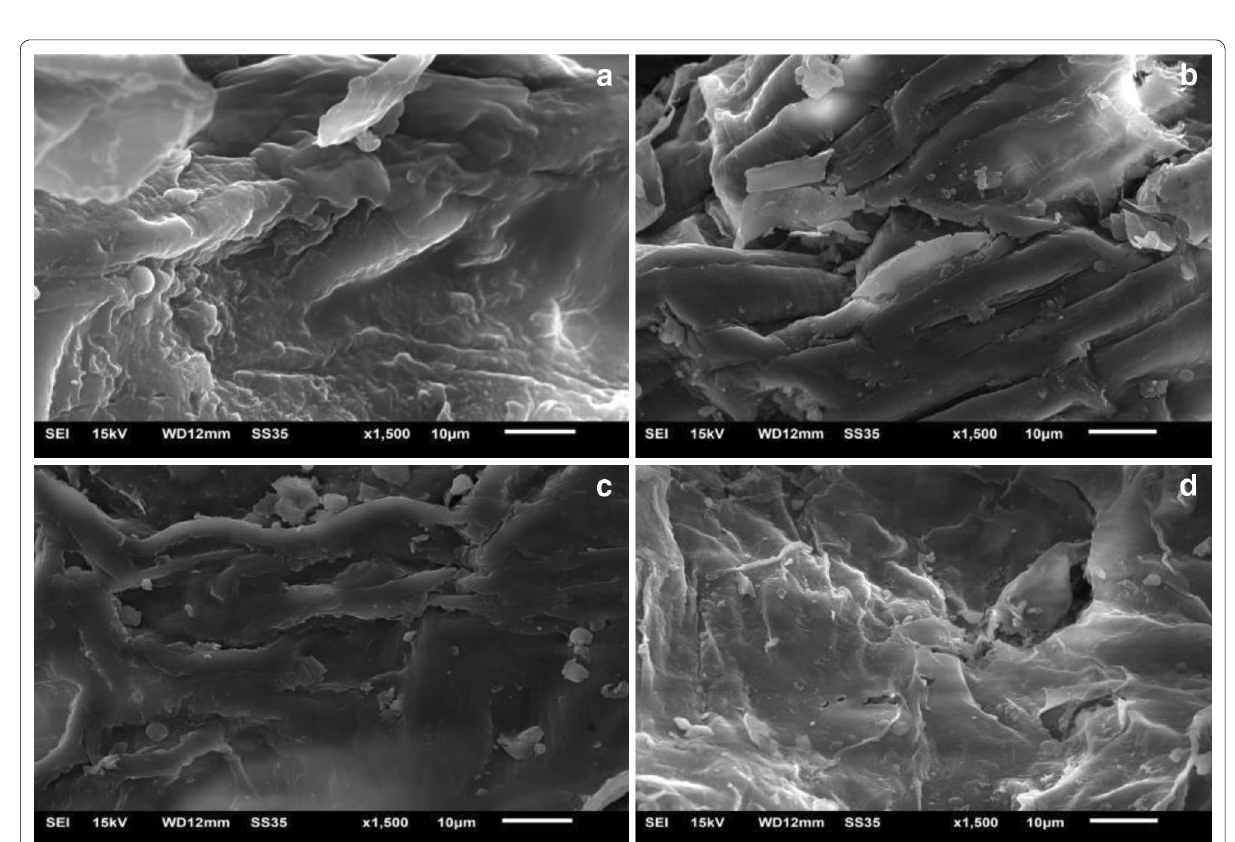
Fig. 4 The scanning electron micrographs of Flos Lonicera Japonicae . Untreated sample ( a ), treated only with pectinase ( b ), treated only with ionic liquids ( c ) and treated with ILEAE ( d